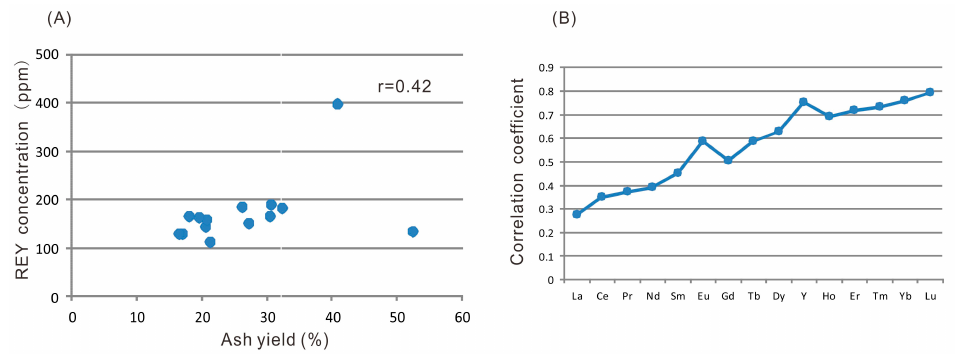
Figure 10. Relations between REY and ash yield ( A ); and between REY-ash correlation coefficients and REY atomic number ( B ).